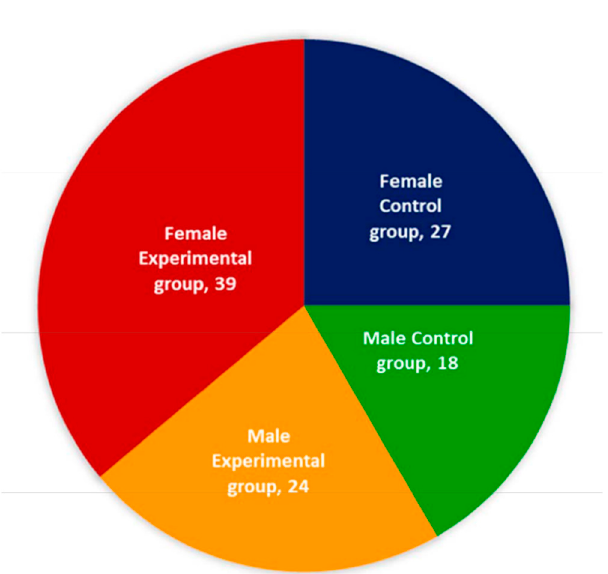
Figure 1. Gender ‐ wise allocation of 63 experimental subjects and 45 control subjects. Figure 1. Gender-wise allocation of 63 experimental subjects and 45 control